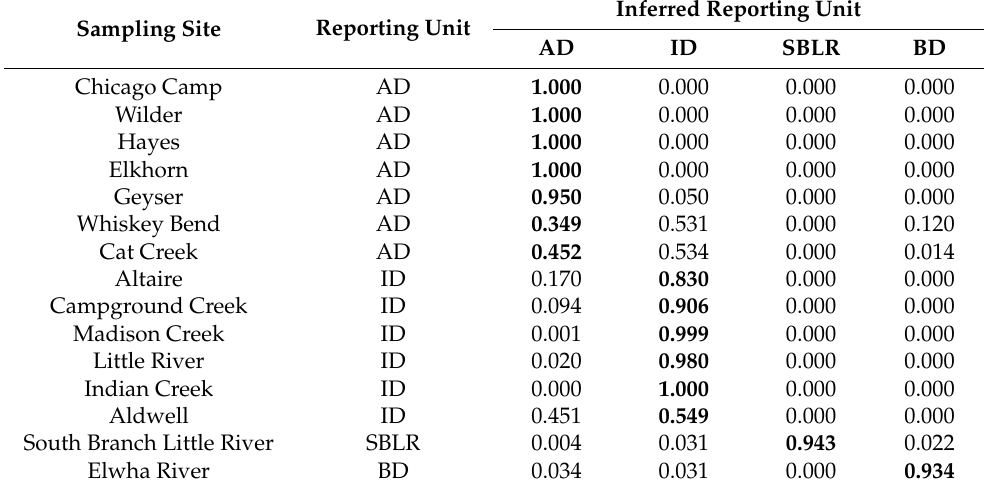
Table A2. The accuracy of assignment of individuals in the reference collections used in GSI analysis (iii) were lower on average than those used in GSI analysis (i) or GSI analysis (ii). Simulations performed on all 567 individuals sampled pre-dam removal using SNP set 1 reflected lower ac- curacy of assignment on average across individuals in each reference collections back to their respective reporting units. Bolded values indicate the highest mean posterior likelihood for inferred population